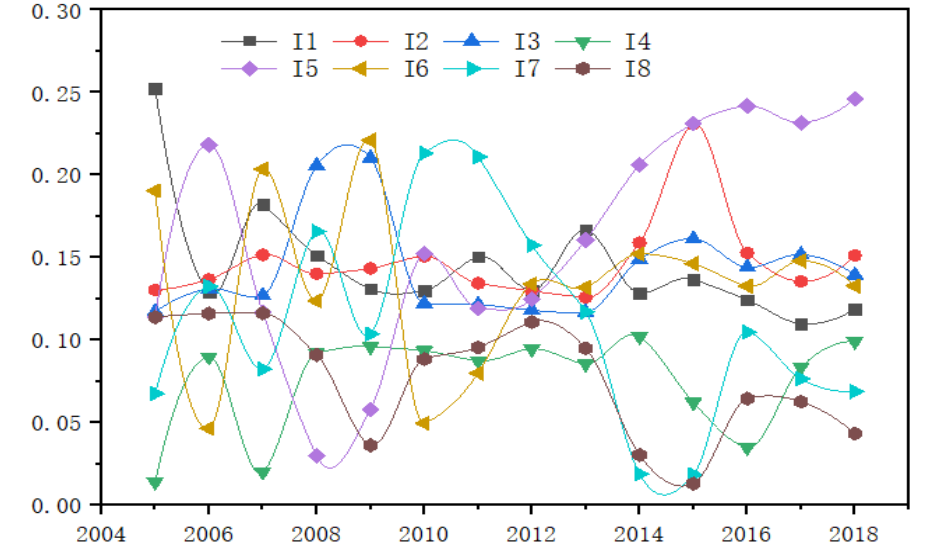
Figure 5. Optimal combination weight of each indicator from 2005 to 2018.